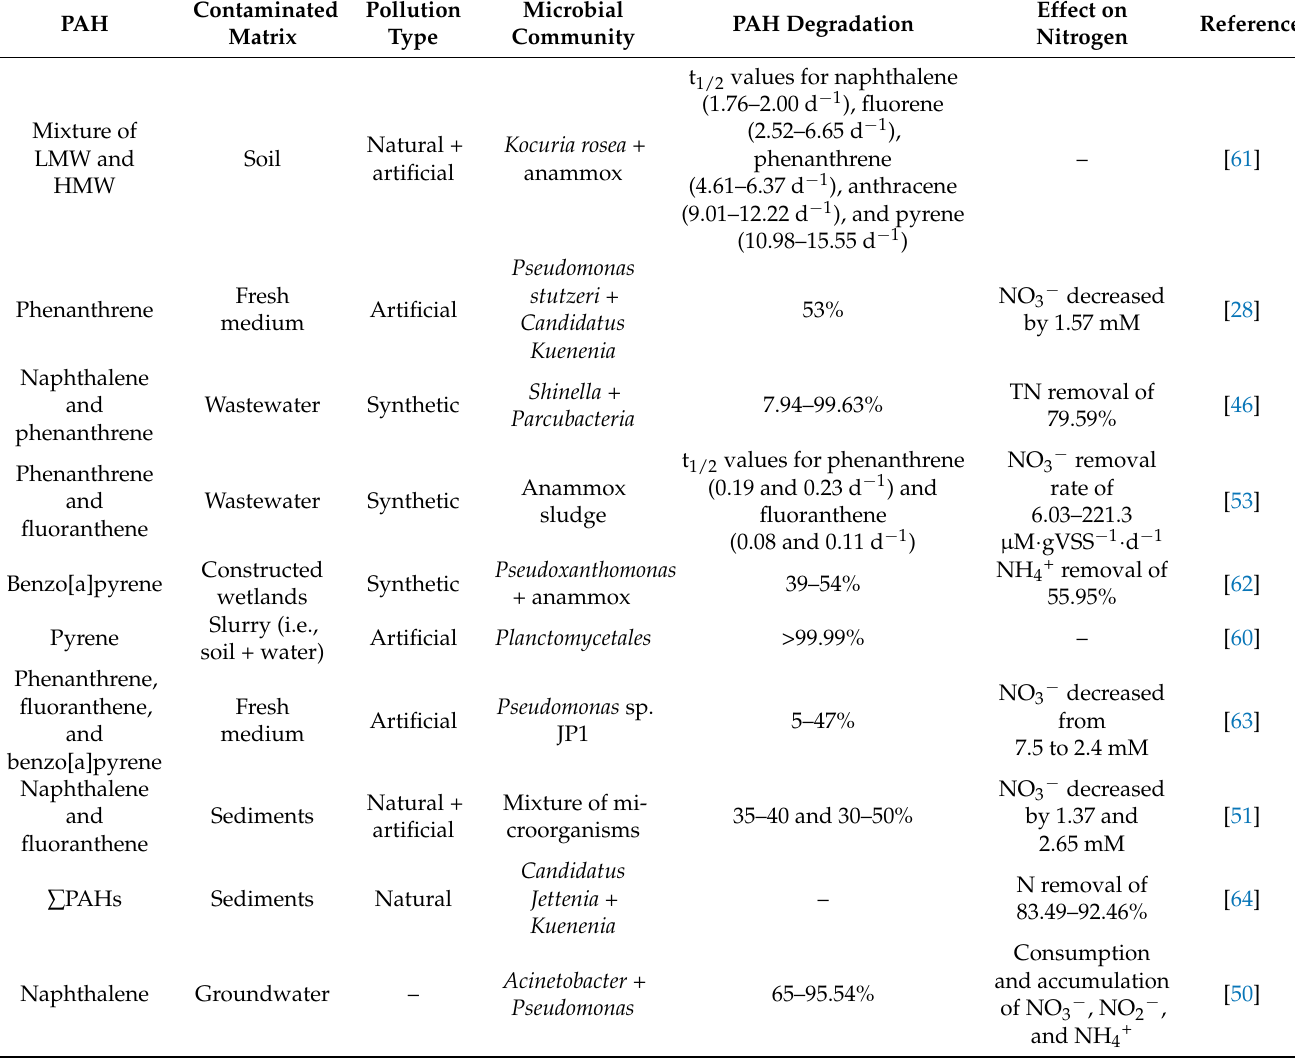
Table 1. Summary of studies reporting polycyclic aromatic hydrocarbon (PAH) degradation coupled with anammox bacteria or processes. LMW = low molecular weight; HMW = high molecular weight; TN = total